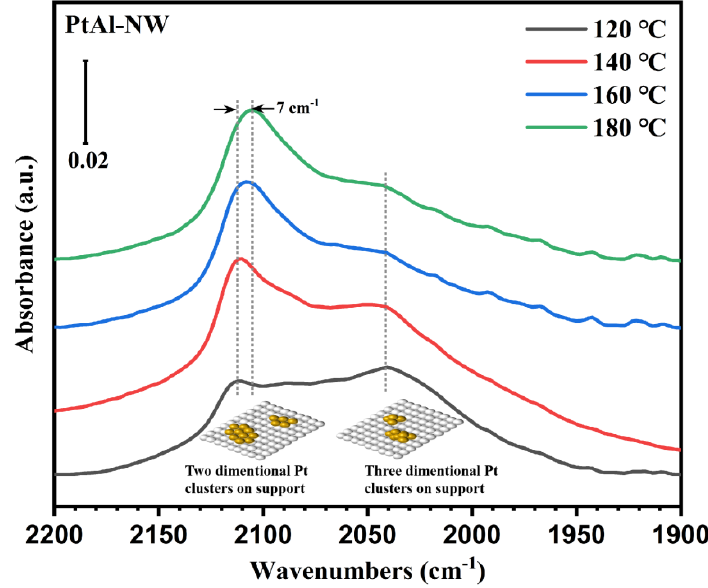
Figure 7. In situ DRIFT spectra over PtAl − NW at temperatures from 120 °C to 180 °C. Reaction conditions: 700 ppm C 2 H 4 , 10% O 2 , N 2 balance, 17 mg catalyst, 50 mL min − 1 flow rate.